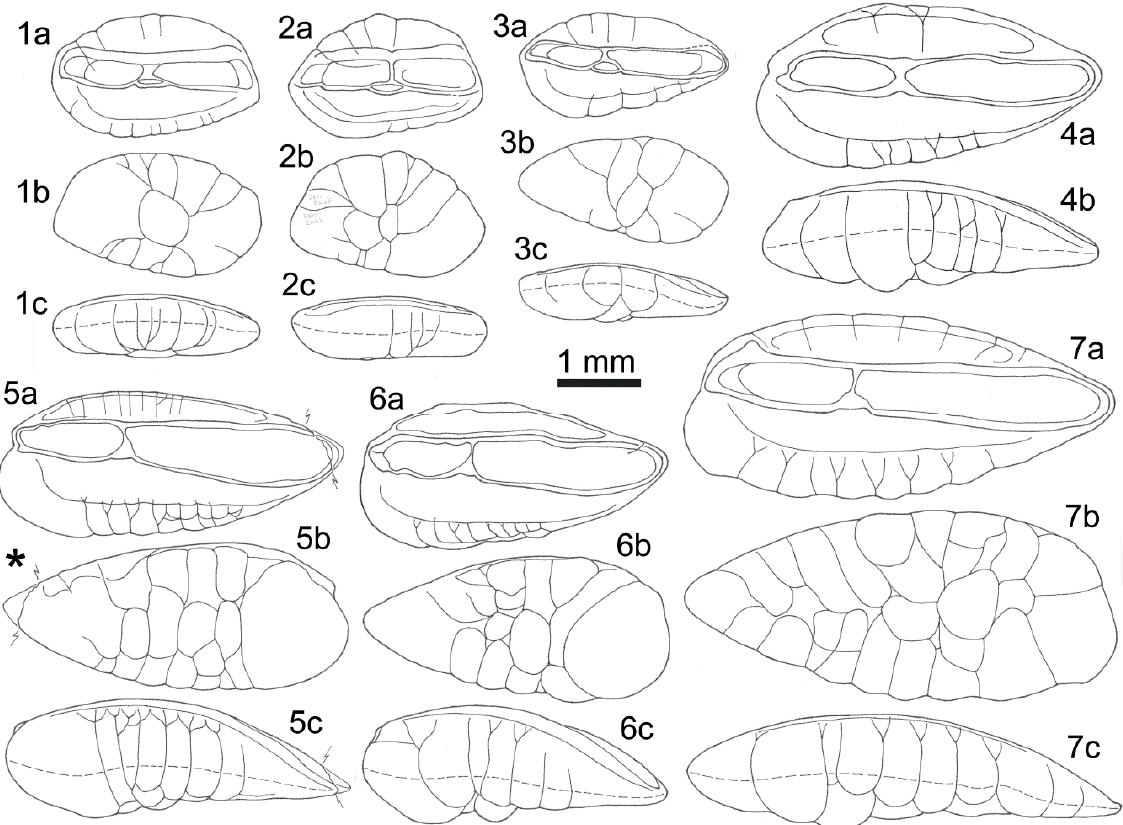
Figure 15. Examples of earlier evolution of trisopterines. ( 1a – c,2a – c ) † Trisopterini, new genus and species 1, Early Oligocene, Rupelian, Kotten Member, borehole Tervoert, Winterswijk, The Netherlands; ( 1a – c ) female, bed 28, 23.8–24.25 m below surface; ( 2a – c ) male, bed 29—base bed 30, 22.3–22.8 m below surface; ( 3a – c ) † Semeniolum rupelense Gaemers, 1984, Early Oligocene, Rupelian, Kotten Member, borehole Tervoert, Winterswijk, The Netherlands, top bed 23—base bed 24, 26.7–27.2 m below surface. ( 4a , b ) † Semeniolum rupelense Gaemers, 1984, Late Oligocene, base of Chattian A, Söllingen, Germany. ( 5a – c , 6a – c ) † Trisopterini, new genus and species 2, Late Oligocene, Chattian A, ( 5a – c ) female, mirror images, indicated with *, ( 6a – c ) male; ( 7a – c ) † “ Trisopterus ” kasselensis n. ssp., Late Oligocene, base of Chattian